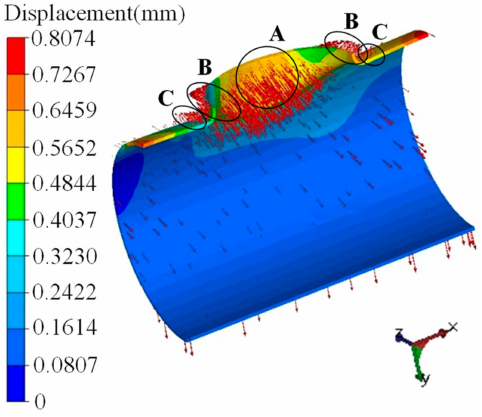
Figure 26. Displacement and velocity fields for